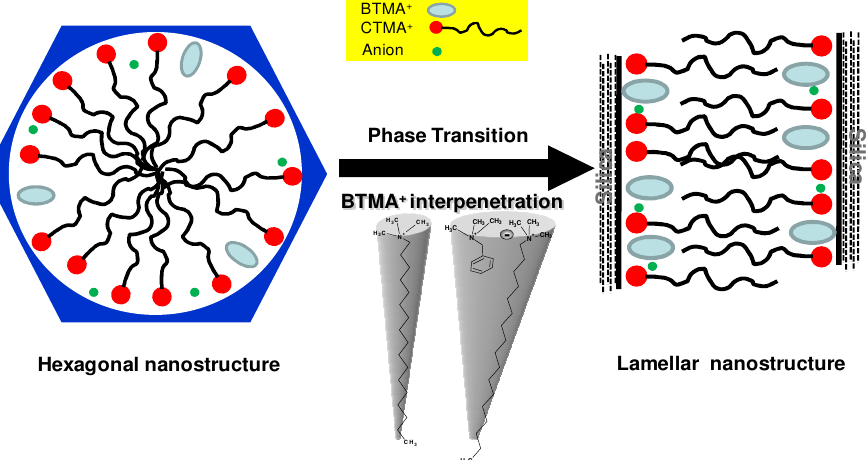
Figure 2 . Influence of BTMA + between head and tail of surfactant and volume increasing, and phase transition from hexagonal to lamellar